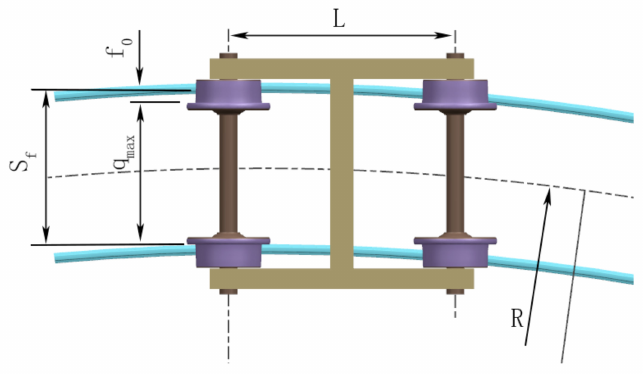
Figure 1. Schematic of the geometrically free-inscribing method.